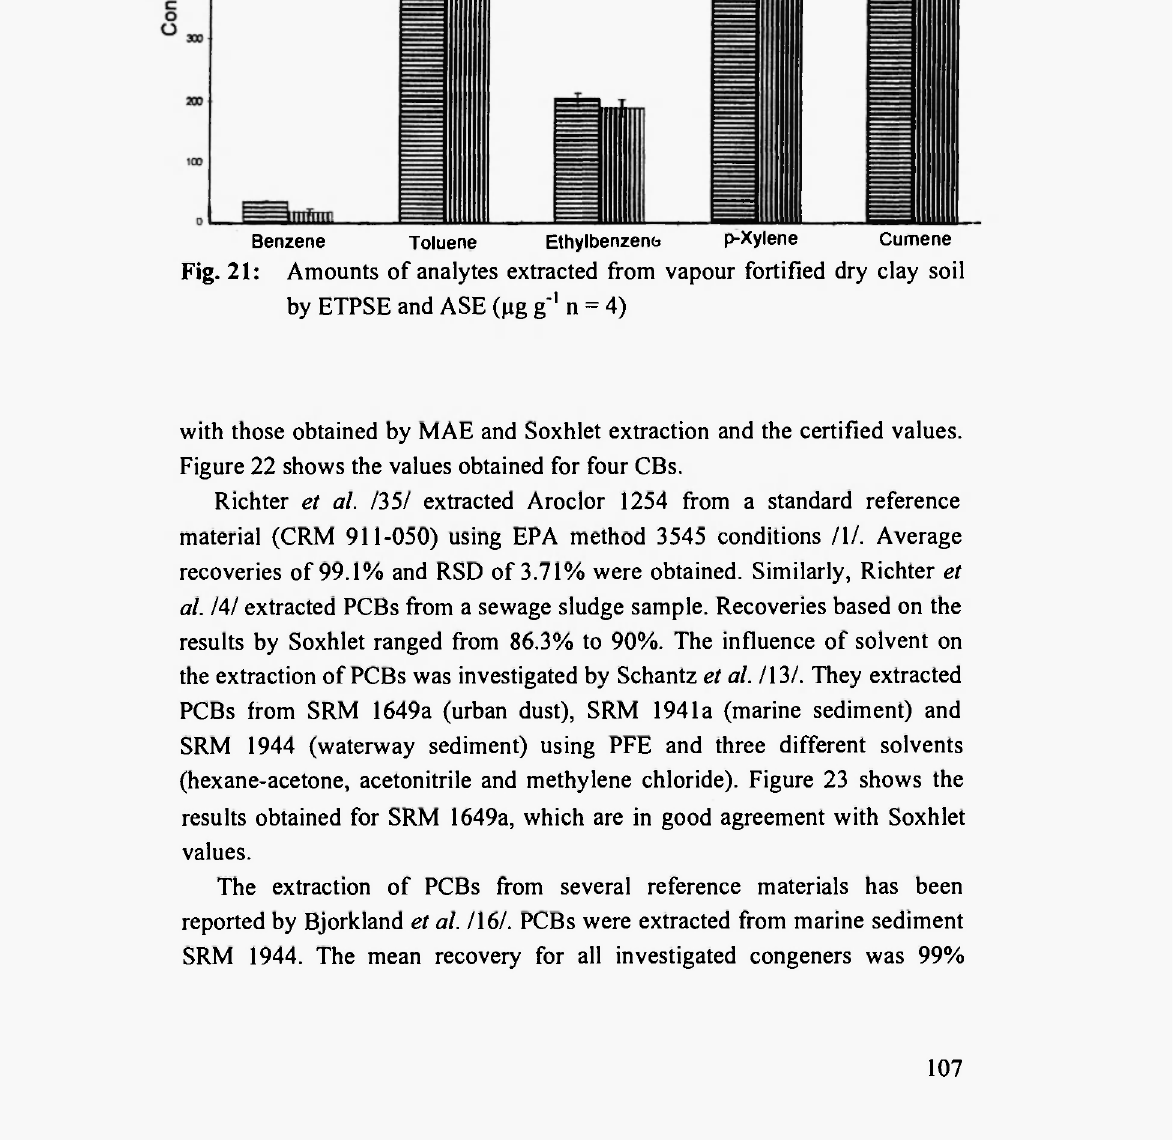
Fig. 21: Amounts of analytes extracted from vapour fortified dry clay soil by ETPSE and ASE fog g 1 η = 4)